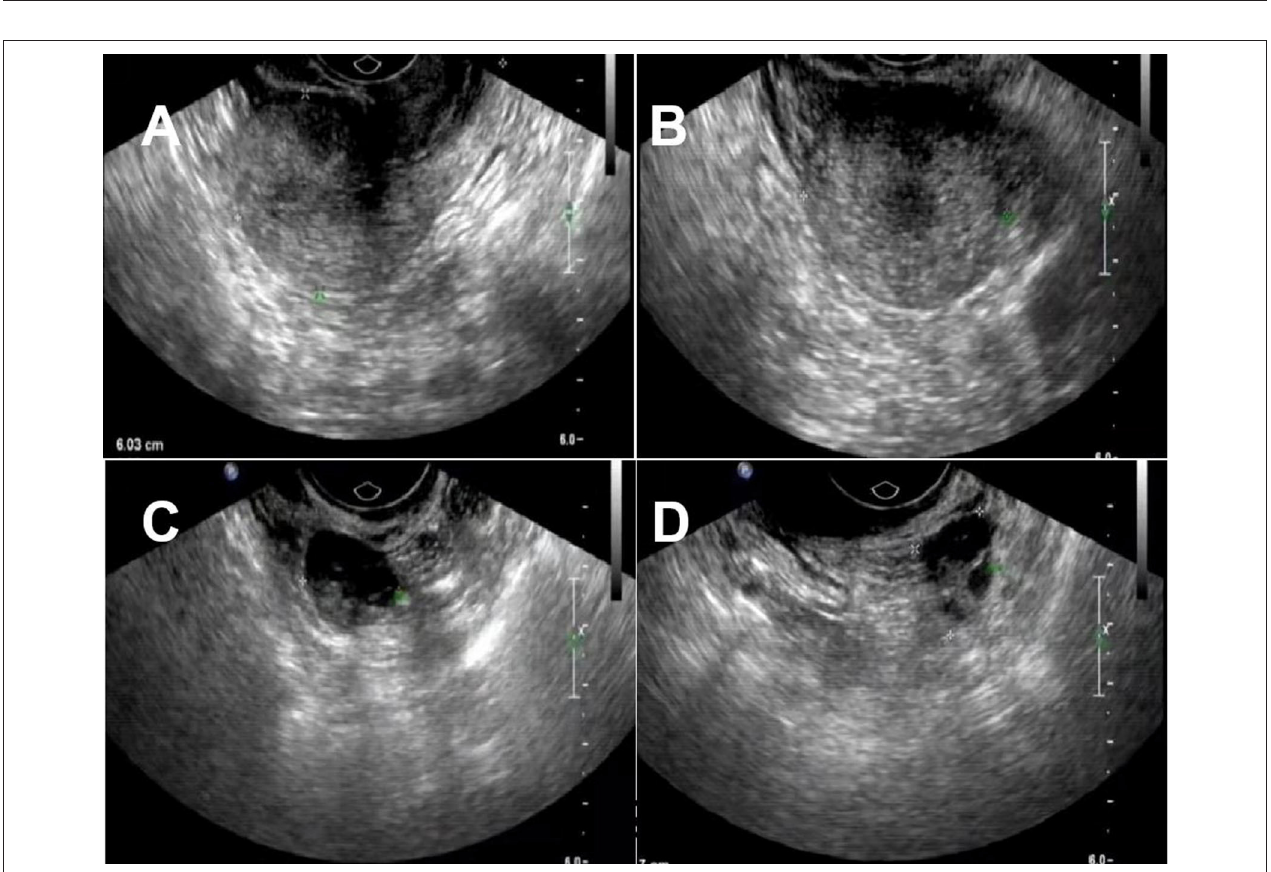
is rare (19). Cystic adenomyosis is a particular type of lesion that originates from the myometrium of the uterus filled with a chocolate-like viscous liquid. So far, only 46 cases of cystic adenomyosis have been reported, including our patient ( Table 1 ). According to the location of the cyst in the uterine wall, cystic adenomyosis is divided into five subtypes